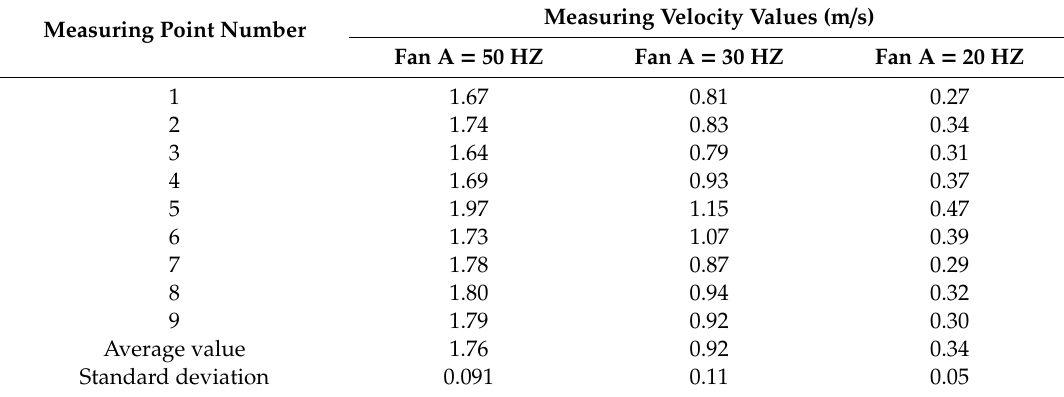
Figure 4. Point distribution: ( a ) The plane distribution position of the detection points; ( b ) The inlet distribution position of the detection points. Table 1. The measured wind velocity values of the nine measuring points at the air inlet.